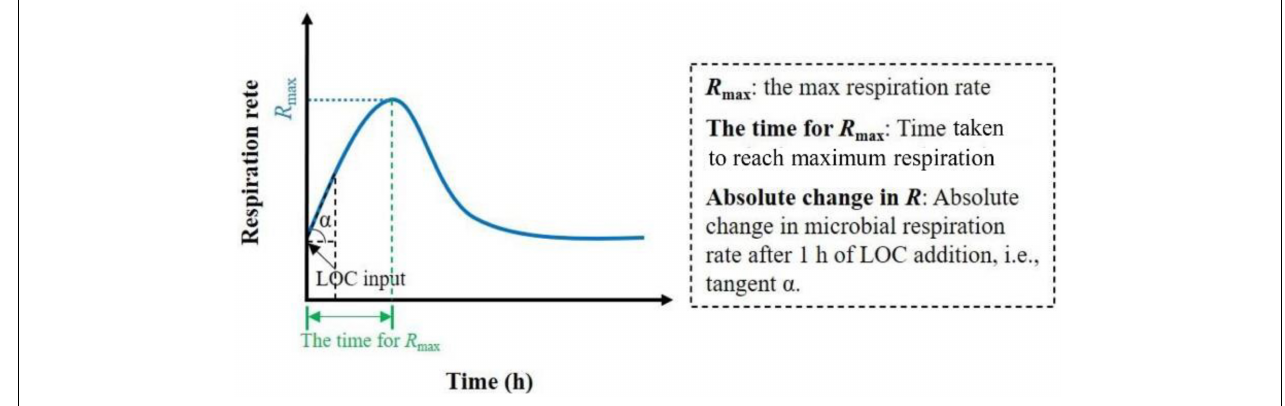
FIGURE 1 | Schematic overview of soil microbial respiration rate after LOC input over time and the definition of relevant parameters.